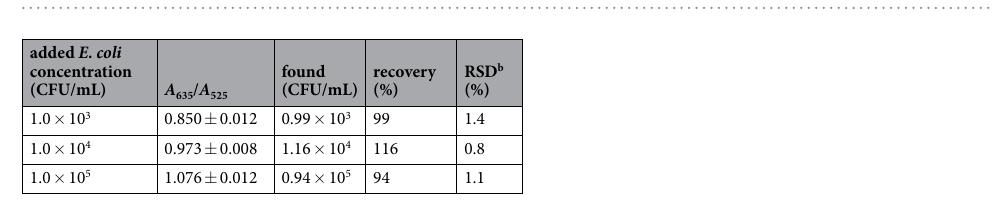
Figure 6. ( A ) UV-vis spectra of dextran@AuNPs with released Con A toward the same concentration (10 7 CFU/mL) of E . coli O157:H7, S . Typhimurium , or L . monocytogenes . ( B ) Histogram of absorption ratio at 635 nm and 525 nm with different kind of pathogenic bacteria. Duncan’s multiple range test, alpha < 0.05; ** p < 0.001.